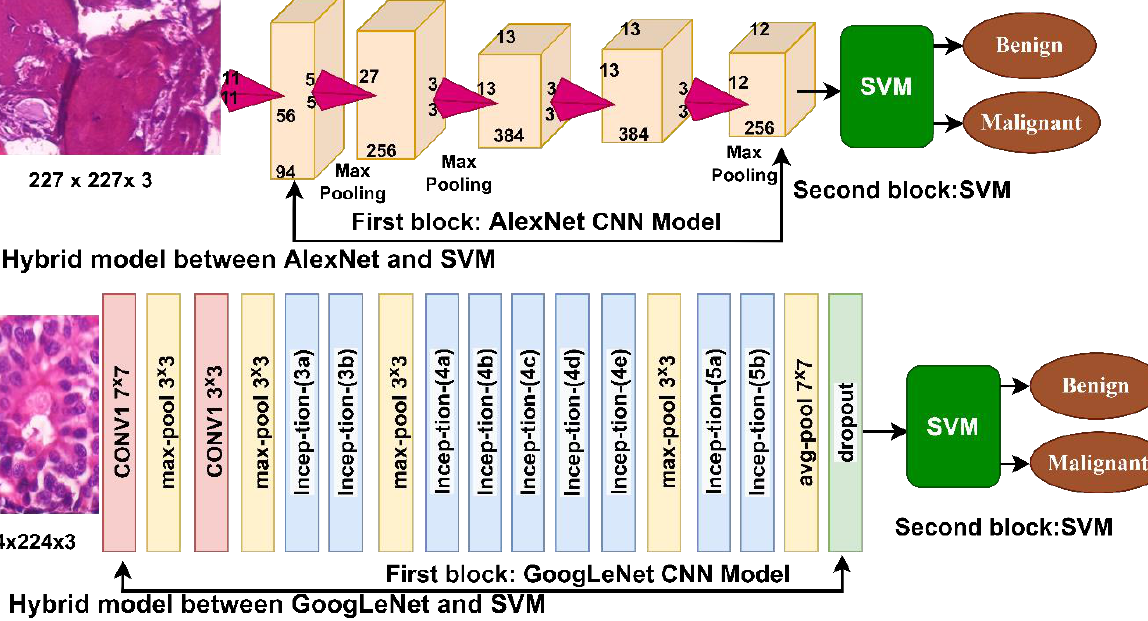
Figure 3. An architecture for HI diagnosis of BC using a hybrid method.